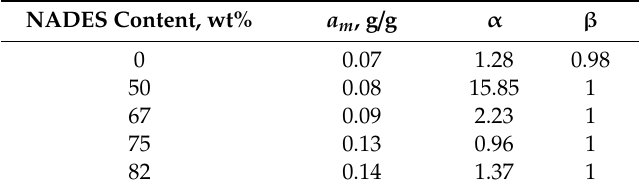
Figure 9. Water sorption isotherms for CS film prepared with LA and with di ff erent concentrations of LA-ChCl NADES ( a ); sorption on active sorption centers ( b ) and in clusters ( c ). Table 3. Refined parameters of the Laatikainen-Lindström isotherm, for CS film prepared with LA without addition of ChCl and with di ff erent NADES